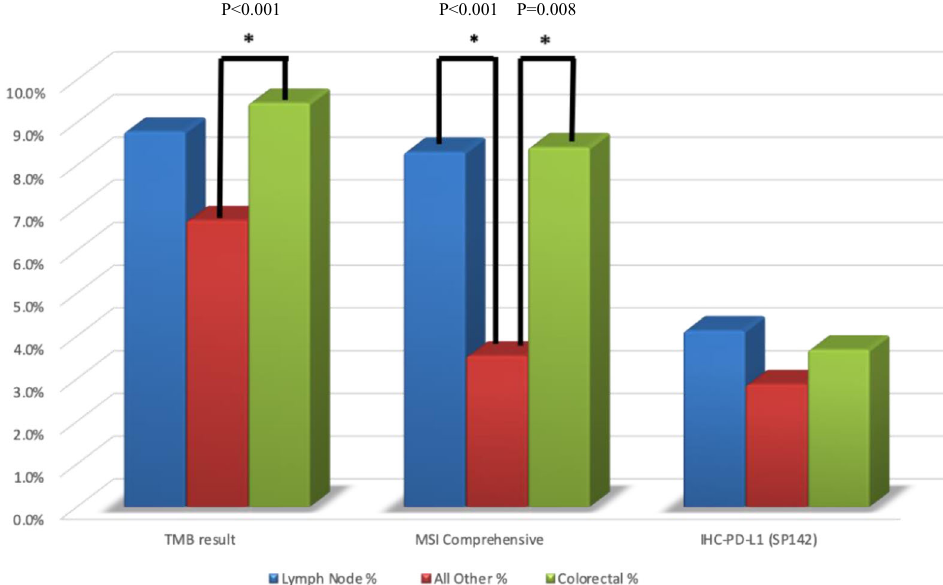
Fig. 3 Difference in tumor mutational burden (TMB), microsatellite instability (MSI) and PD-L1 among lymph nodes, distant metastases, and primary colorectal tumors. Connective lines and asterisks indicate statistical signi fi